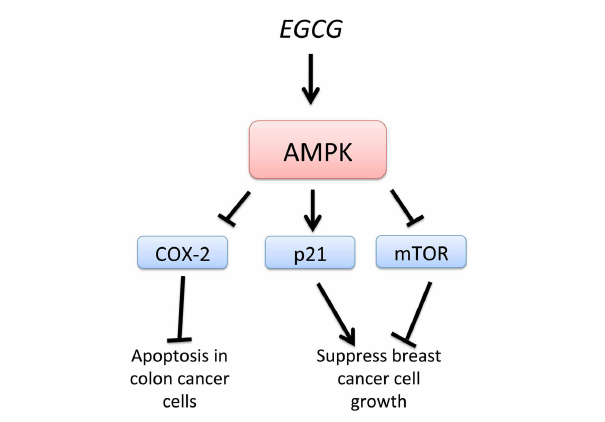
FIGURE 5 | Schematic representation ofAMPK-dependent anti-cancer effects of EGCG . Epigallocatechin-3-gallate, EGCG, stimulates AMPK, leading to suppression of breast cancer cell growth by inhibition of mTOR and activation of p21. Inhibition of COX-2 by EGCG-induced AMPK activation leads to apoptosis in colon cancer